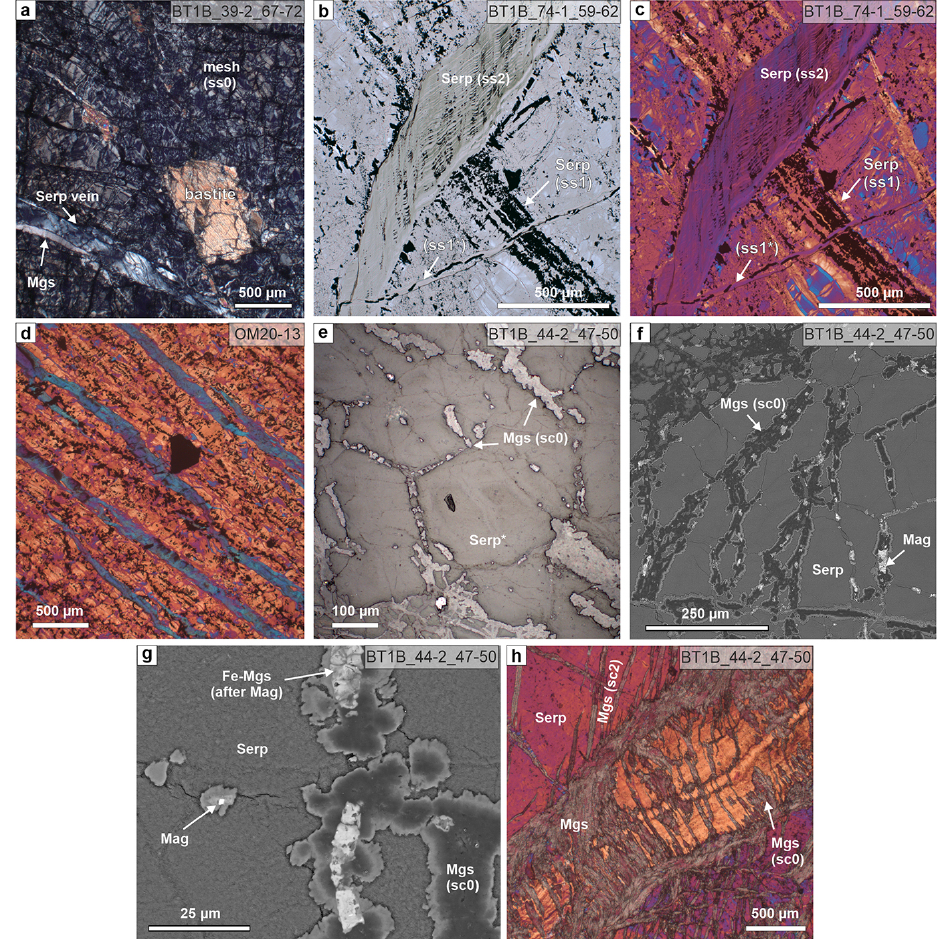
Figure 2. Serpentine veins (a–d) and pseudomorphic carbonate microstructures after serpentine textures (e, f) in serpentinite. (a) Mesh (ss0) and bastite textured serpentinite cut by a serpentine vein; a magnesite vein exploits the vein–host rock interface of the serpentine vein under crossed polarizers (xpol). (b) Plane-polarized (ppol) micrograph of a wide serpentine–magnetite vein (ss1) cut by a light green, banded serpentine crack–seal vein (ss2), which is in turn cut by a narrow serpentine–magnetite vein (ss1 ∗ ). (c) Same area as in (b) , with xpol and 1 λ plate. (d) Clustered cleavage-parallel serpentine veins in foliated serpentinite north of site BT1 with strong crystallographic preferred orien- tation and flattened magnetite mesh cells. The large black grain is Cr spinel (xpol with 1 λ plate). (e) Reflected light image and (f) BSE image of a magnesite vein network (sc0) tracing polygonal serpentine mesh (Serp ∗ ) delineated by former magnetite in serpentinite. (g) Detailed BSE image of sc0 magnesite showing pseudomorphic replacement of magnetite by Fe magnesite (similar replacements are known from listvenites elsewhere; Menzel et al., 2018) and compositional zoning with Fe-bearing euhedral to dendritic magnesite rims. (h) Serpentine crack–seal vein (orange) in serpentinite, with partial pseudomorphic replacement by magnesite and cross-cut by zoned magnesite–dolomite veins (sc2) (xpol with 1 λ plate). For abbreviations of minerals and vein generations used in all figures, see Tables 1 and